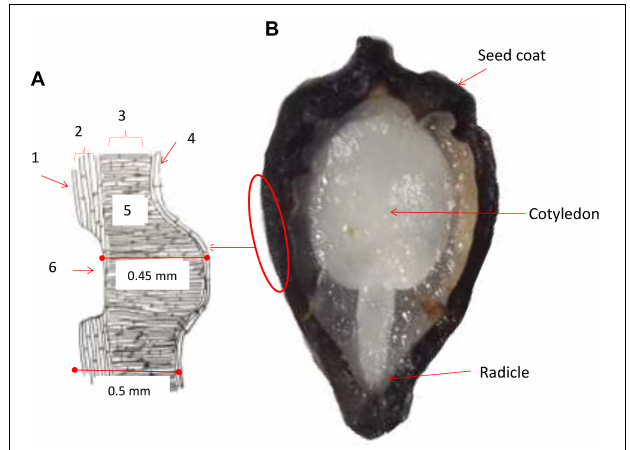
FIGURE 1 | Cross sections of a purple passion fruit ( Passiflora edulis f. edulis Sims) seed coat (A) and the entire seed (B) . In the diagram of the seed coat to the left, a seed pit is shown. The seed pit is the depth of the seed coat cuticle. Approximate widths of the seed coat are 0.45 mm below the seed pit and 0.5 mm on either side of the seed pit. Numbers around the diagram indicating the following: 1 = exotesta; 2 = mesotesta; 3 = exotegmen; 4 = hyaline cells; 5 = palisade cells; and 6 = seed pit. The radicle and cotyledon of the seed embryo indicated in the seed cross section.